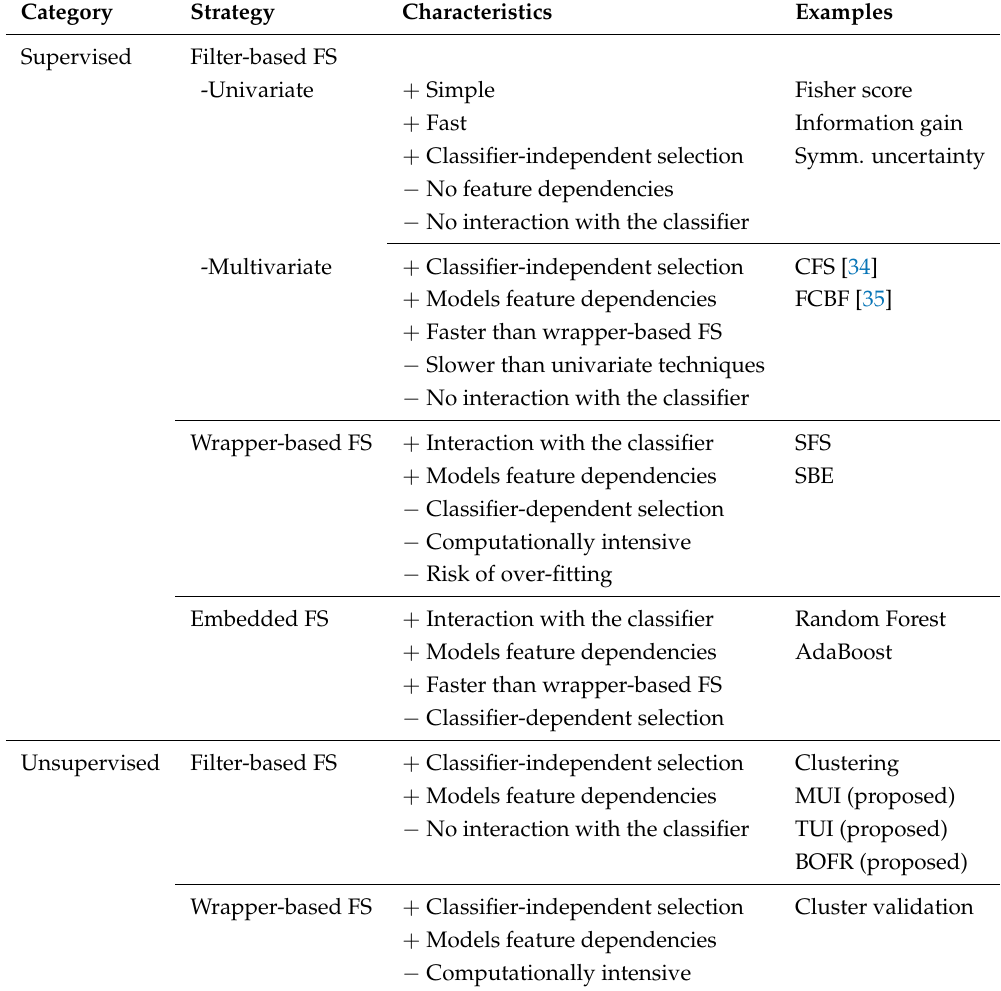
Table 1. Categorization of feature selection (FS) techniques with respect to their main characteristics: the table follows [3] and additionally addresses unsupervised FS techniques (SFS: Sequential Forward Selection; SBE: Sequential Backward Elimination; CFS: Correlation-based Feature Selection; FCBF: